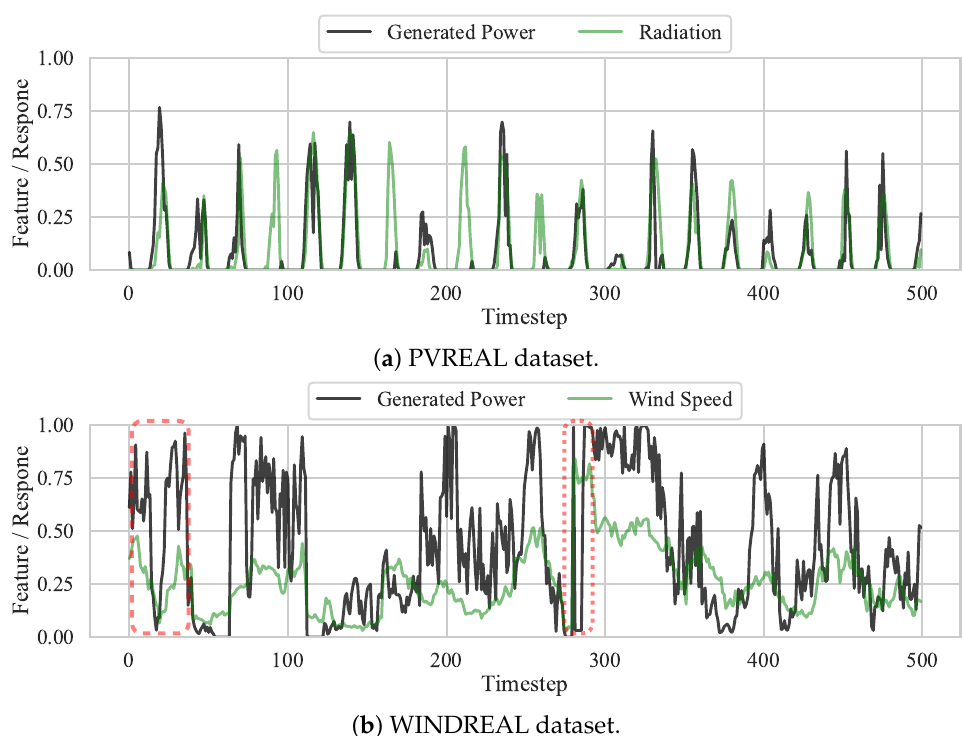
Figure 7. Time series plots of most relevant features for power forecasts from day-ahead weather forecasts and the historical power measurements. The radiation, as well as the historical power, shows a typical Gaussian-shaped behavior during the day. The dashed rectangle shows a potential bad weather forecast of the wind speed. The dotted rectangle for the WINDREAL dataset indicates a typical pattern of feed-in management